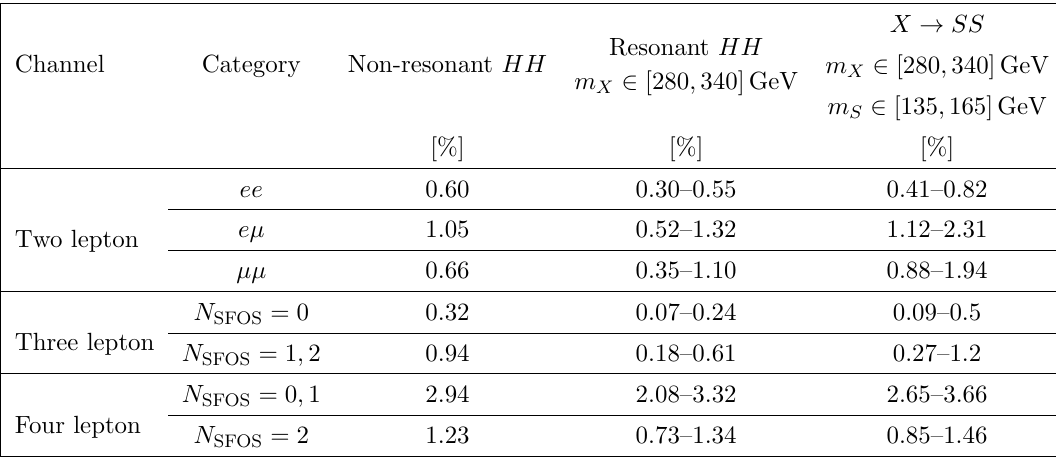
Table 12 . The (cid:12)nal acceptance times selection e(cid:14)ciencies in the 4 W channel for non-resonant, resonant, and SS signal samples after all selection criteria are applied. Acceptance times selection e(cid:14)ciency is de(cid:12)ned as the ratio of reconstructed signal events passing all selection criteria to the number of generated signal events that are (cid:12)ltered for the corresponding channel. The generator (cid:12)lter e(cid:14)ciencies are 4 : 4 (cid:2) 10 (cid:0) 3 for the two same-sign lepton channel, 4 : 2 (cid:2) 10 (cid:0) 3 for the three lepton channel, and 5 : 1 (cid:2) 10 (cid:0) 4 for the four lepton channel. All numbers are given as percentages. Open